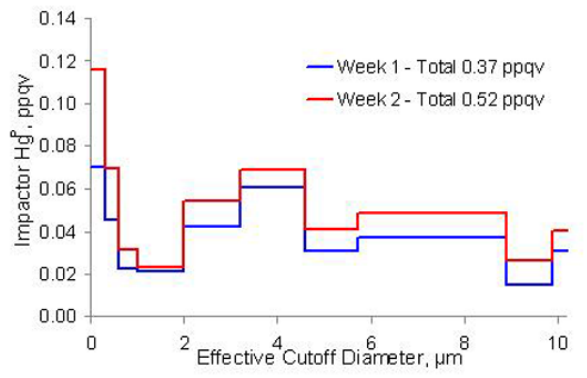
Fig. 5. Size Distribution of Hg P at Thompson Farm in spring 2010 which shows a distribution of fine and coarse size